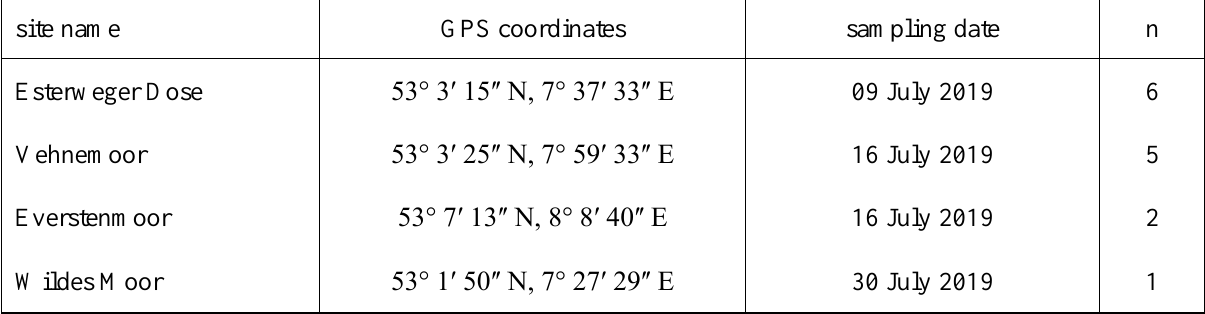
Table A1. List of regional reference sites in near-natural or restored bogs. n = number of (surface water) samples.